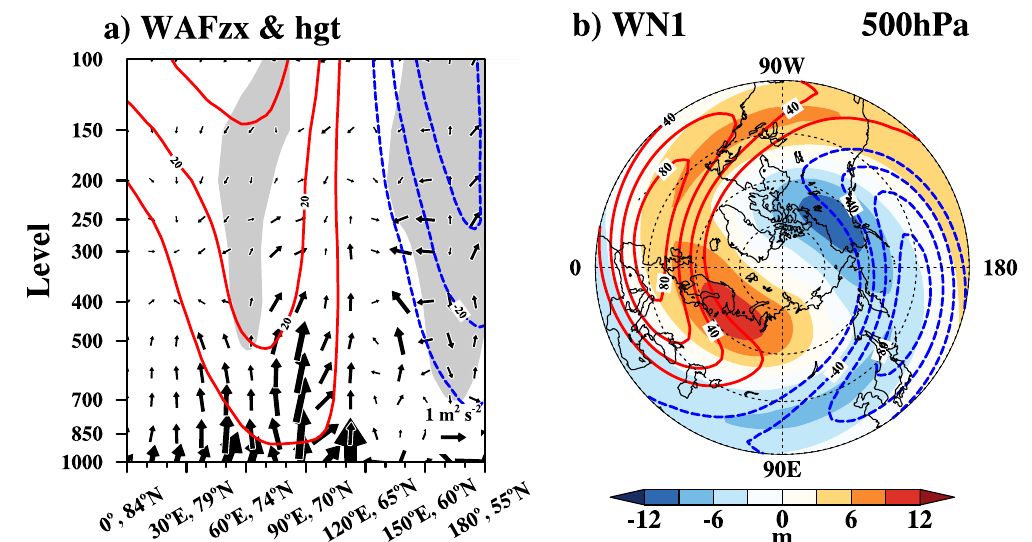
Fig. 3 The BK sea ice-related winter atmospheric circulations. a Cross-section of geopotential heights (m, contour) and the zonal and vertical components of the WAF anomalies (m 2 s − 2 , vector) regressed onto the negative winter BK sea ice index along the green line in Fig. 2a and extending northwestward and southeastward to grids (0°, 84°N and 180°, 55°N). The vertical component of the WAF in ( a ) is multiplied by 100. Gray shading in ( a ) denote geopotential height anomalies signi fi cant at the 90% con fi dence level. b Winter WN1 component of geopotential heights at 500-hPa (m, shading) regressed onto the negative winter BK sea ice index and the climatological WN1 (m, contour). Contour intervals are 10 m in ( a ) and 20 m in ( b